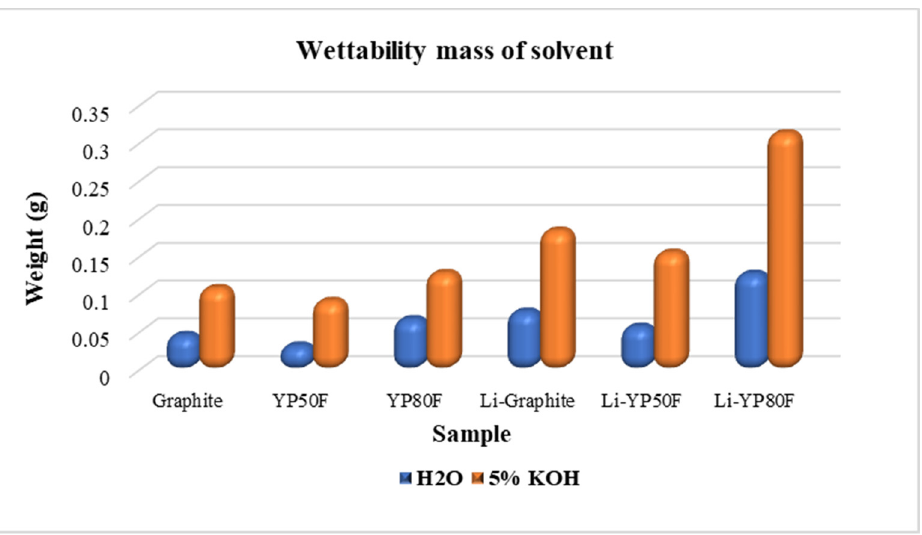
Figure 7. Bit-graph. The wettability of the carbon samples. Figure 8 expresses the Raman spectra of the LiOH-treated graphite, YP50F and